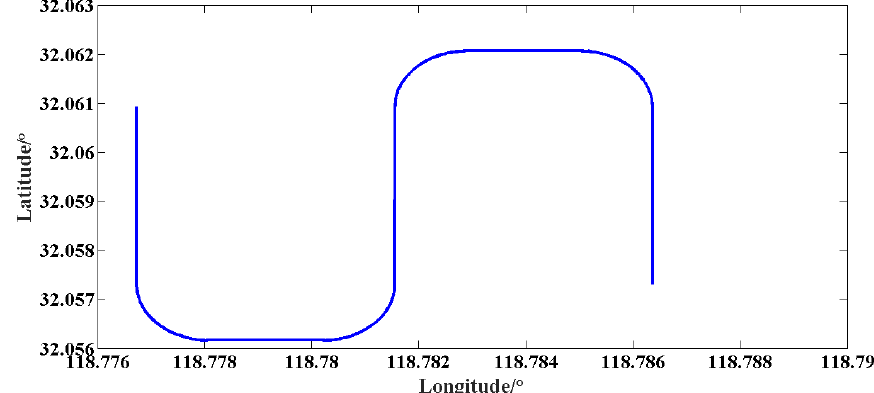
Figure 12. S-shaped maneuver path.